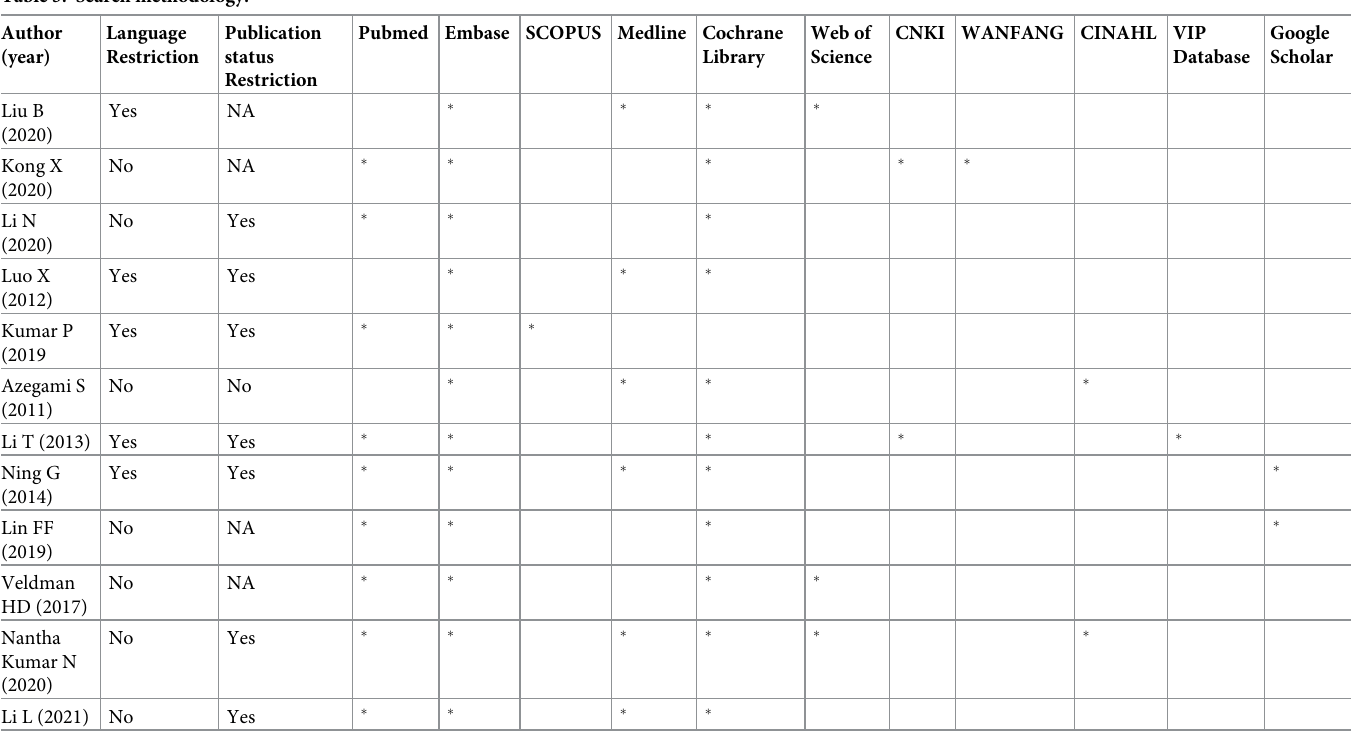
Table 3. Search methodology.